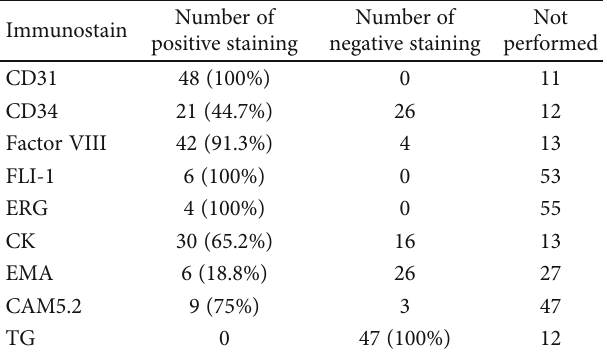
Table 2: Immunohistochemical features.